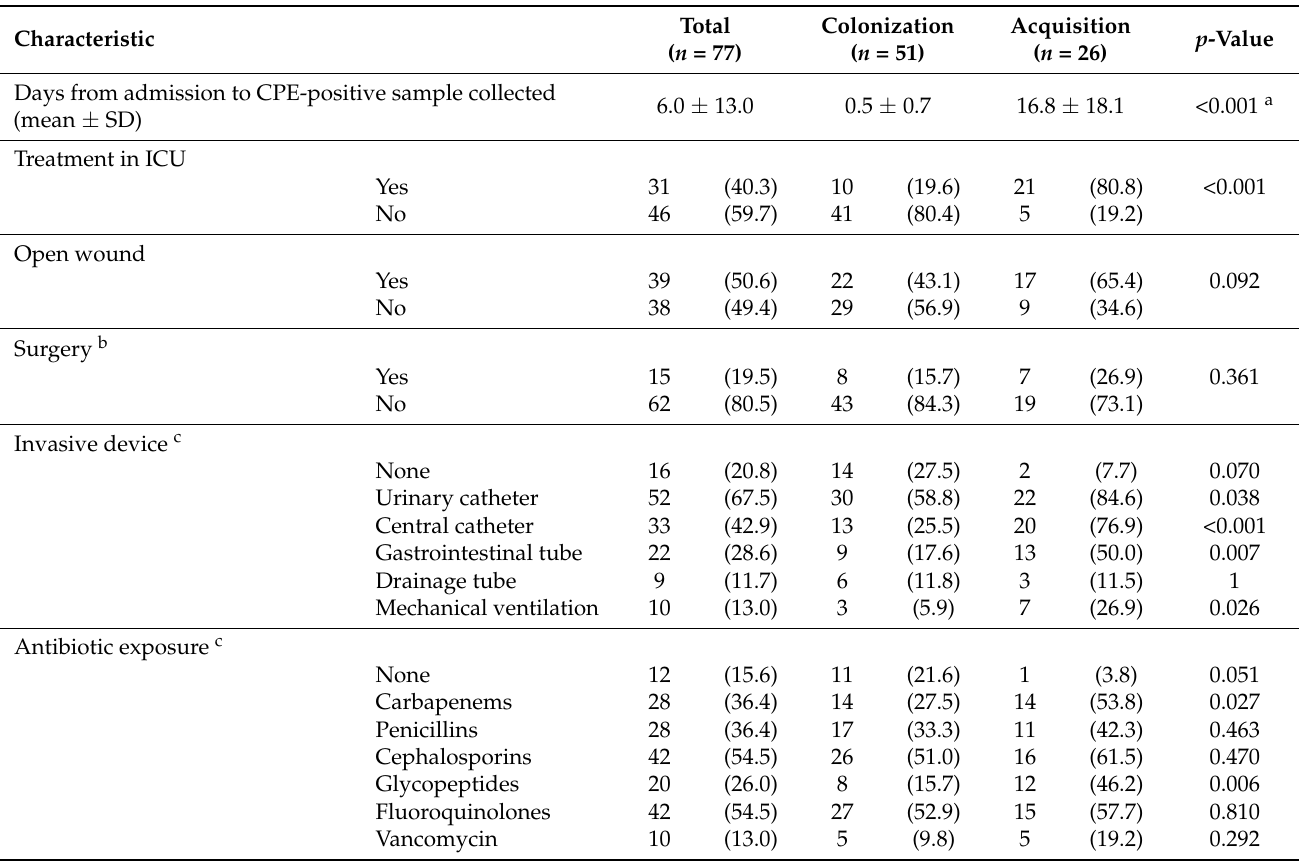
Table 2. Differences in clinical risk factors associated with CPE colonization and